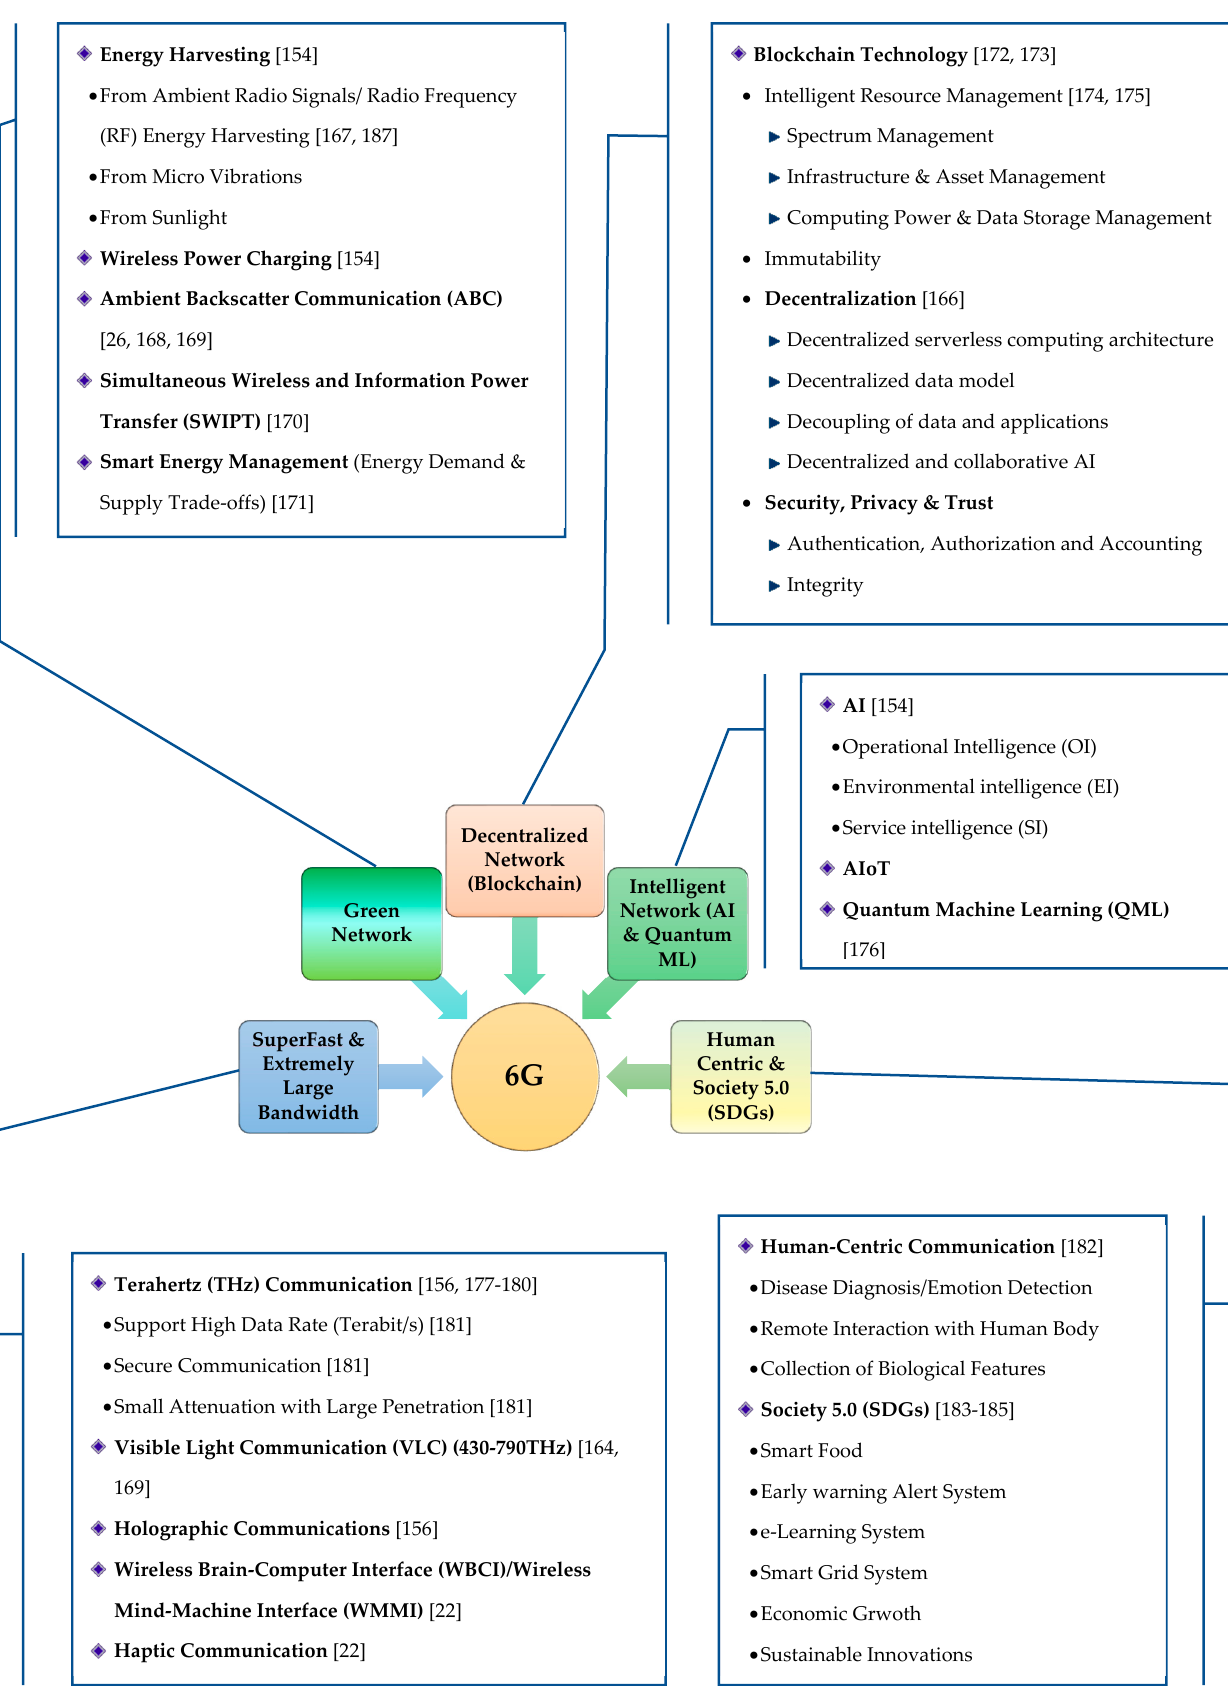
Figure 5. Vision & Key Features of 6G Figure 5. Vision and key features of 6G